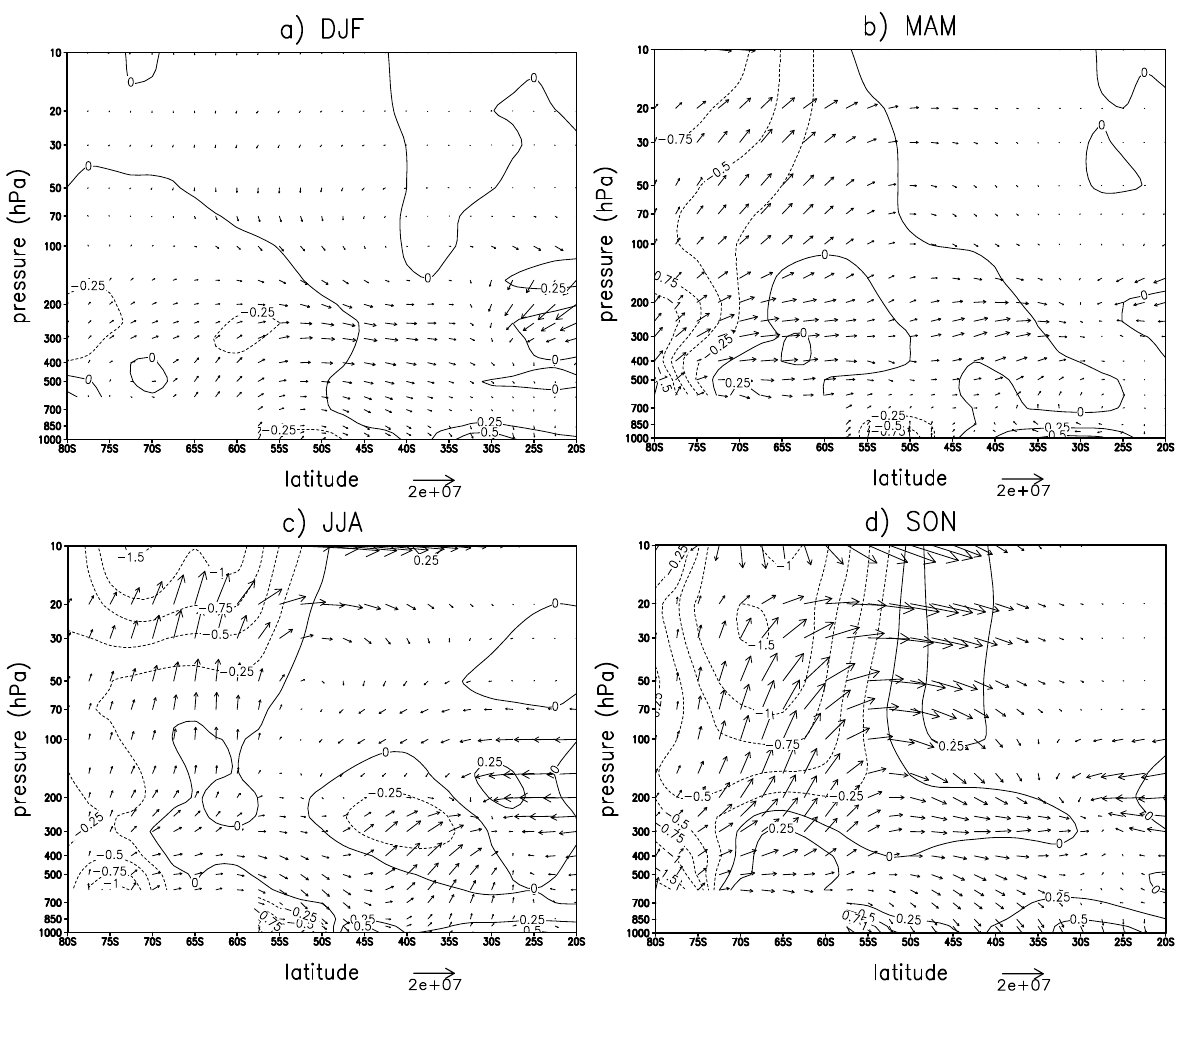
Fig. 6. Same as Fig. 5, but for El Ni˜no minus La